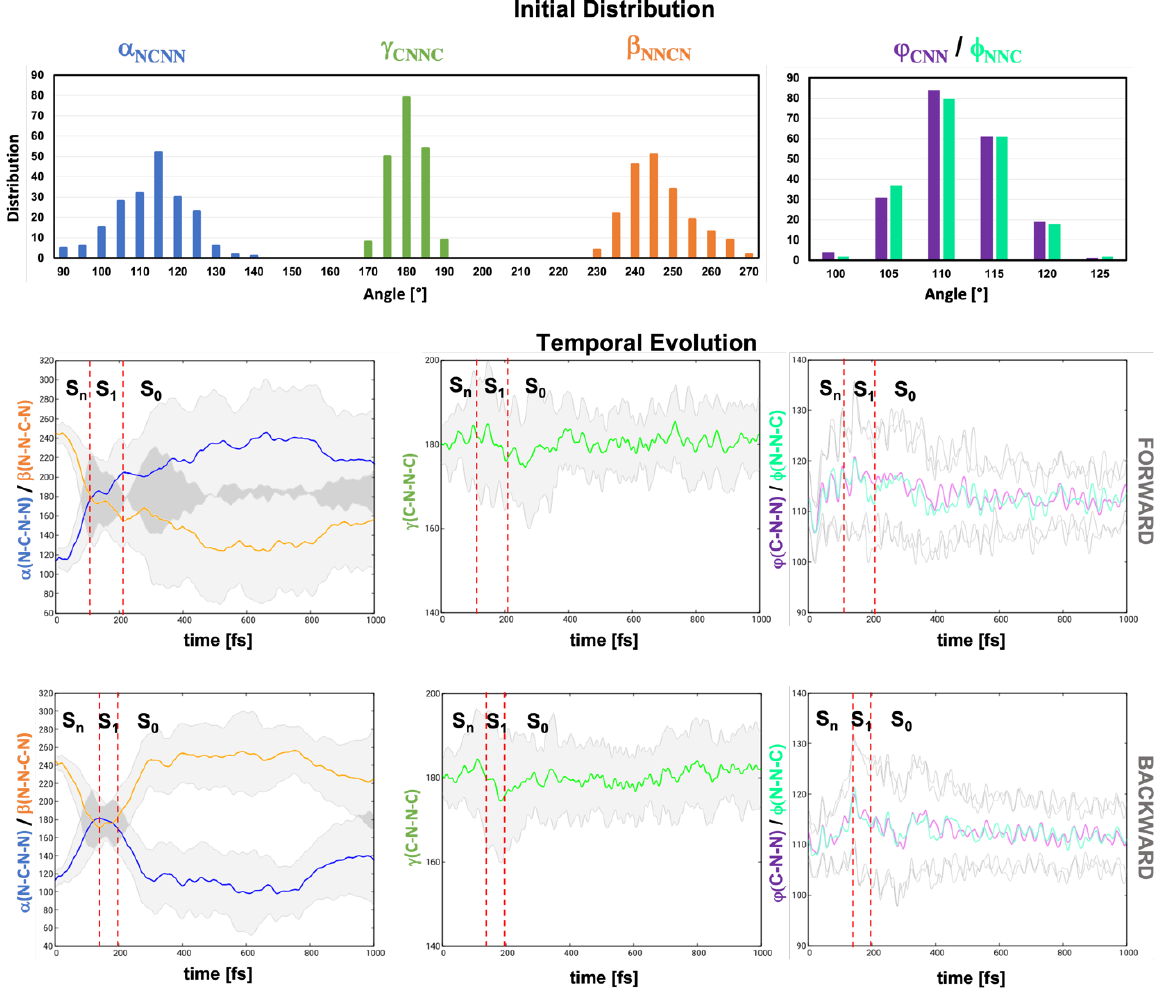
Figure 6. Initial distribution od dihedrals α (N 1 -C 2 -N 3 -N 4 ) (blue), β (N 3 -N 4 -C 5– N 6 ) (orange), γ (C 2 -N 3 -N 4 -C 5 ) (green) and angles ϕ (C 2 -N 3 -N 4 ) (violet) and φ (N 3 -N 4 -C 5 ) (top). Average evolution of α , β , γ , ϕ and φ undergoing forward (middle) and backward (bottom) pedalo -type motion. Gray areas represent the standard deviation with respect to the average value. Red dashed lines indicate average S 2 /S 1 and S 1 /S 0 hopping times.